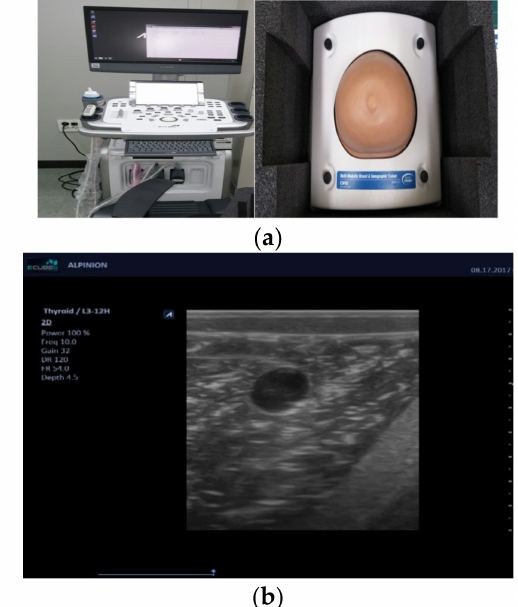
Figure 6. ( a ) Commercial ultrasound machine with breast phantom and ( b ) breast phantom